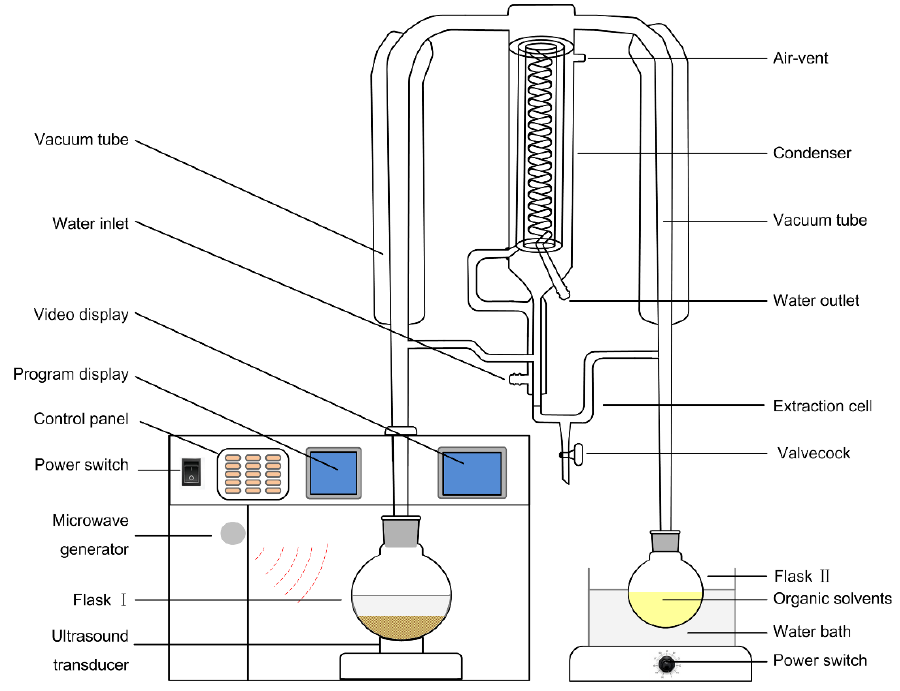
Figure 2. Schematic diagram of UMASDE device.